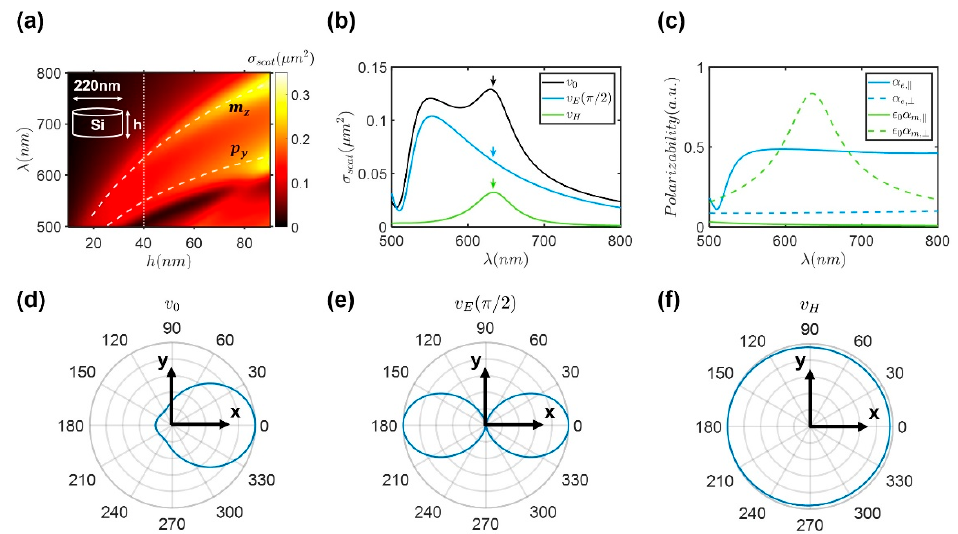
Figure 2. The optical response of a nanodisk under single beam and coherent excitation. ( a ) σ scat spectra of a single nanodisk with height ranging from 10 to 90 nm. The disk radius is fixed to 110 nm. The nanodisk is suspended in the air and is illuminated by v . The white dashed lines are the 0 traced spectral maxima position of the dipole moment. ( b ) σ scat spectra of the r = 110 nm and h = 40 nm nanodisk under v (black), ( / 2) v (blue) and v (green) excitations, respectively. ( c ) The 0 E H and are indeed the dominant polar ‐ electric and magnetic polarizabilities indicate that , , m (cid:0) e